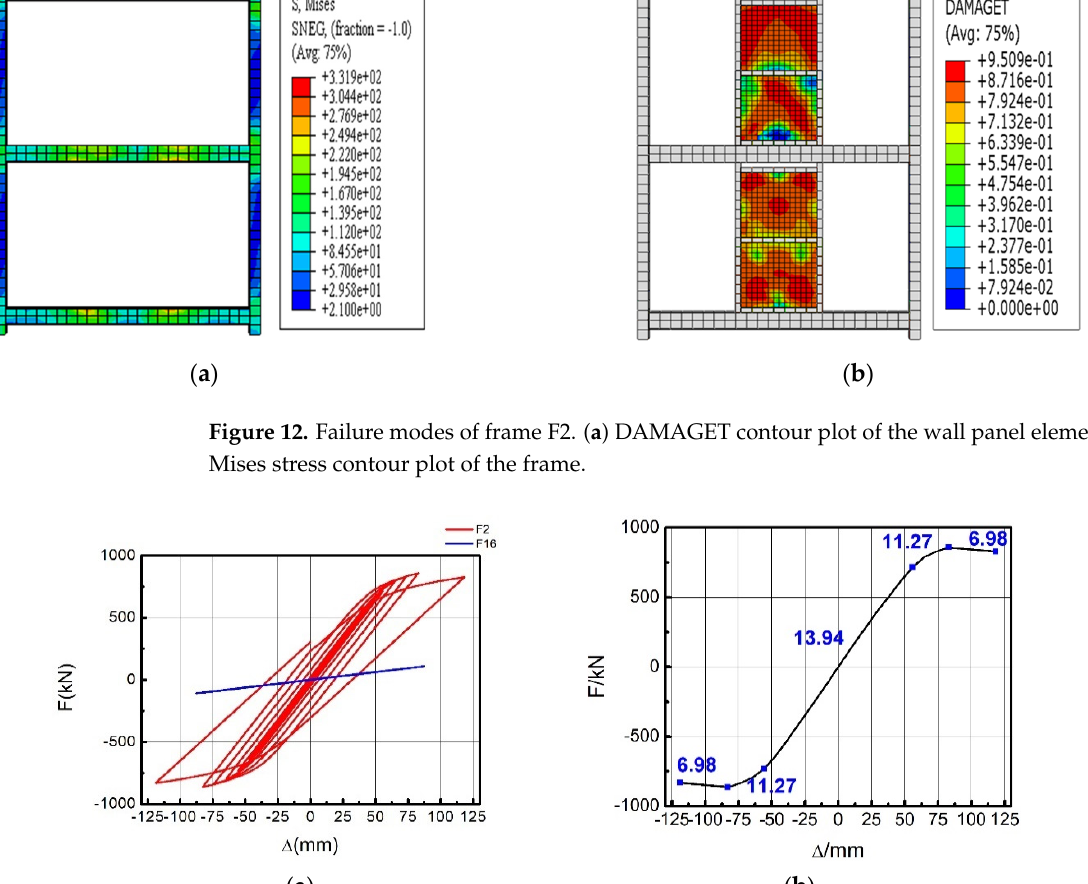
Figure 13. Hysteresis curves and the skeleton curve of frame F2. ( a ) Hysteresis curves of F2 and F16; ( b ) skeleton curve of F2.